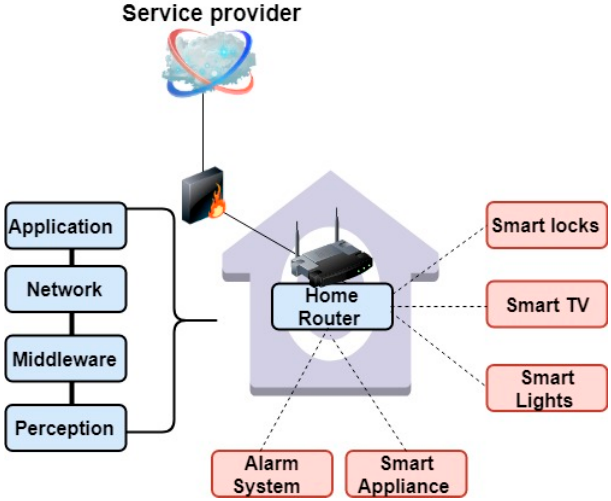
Figure 1. Smart home architecture .